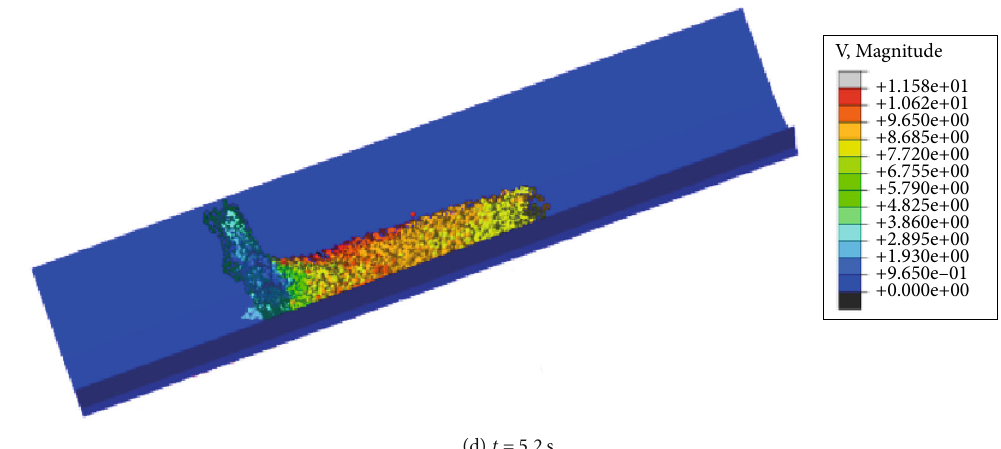
Figure 5: Process of debris fl ow impacting the retaining